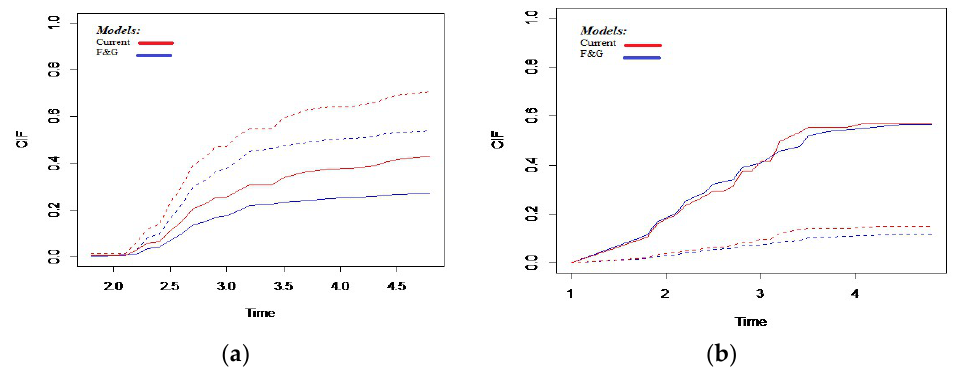
Figure 1. Comparison of the CIF’s Current Model (26% Masked Observations) with F&G Model for: ( a ) Cause 1, solid line: X = 0.5. Dashed line: X = −0.5. ( b ) Cause 2, solid line: X = 0.5. Dashed line: X = −0.5.